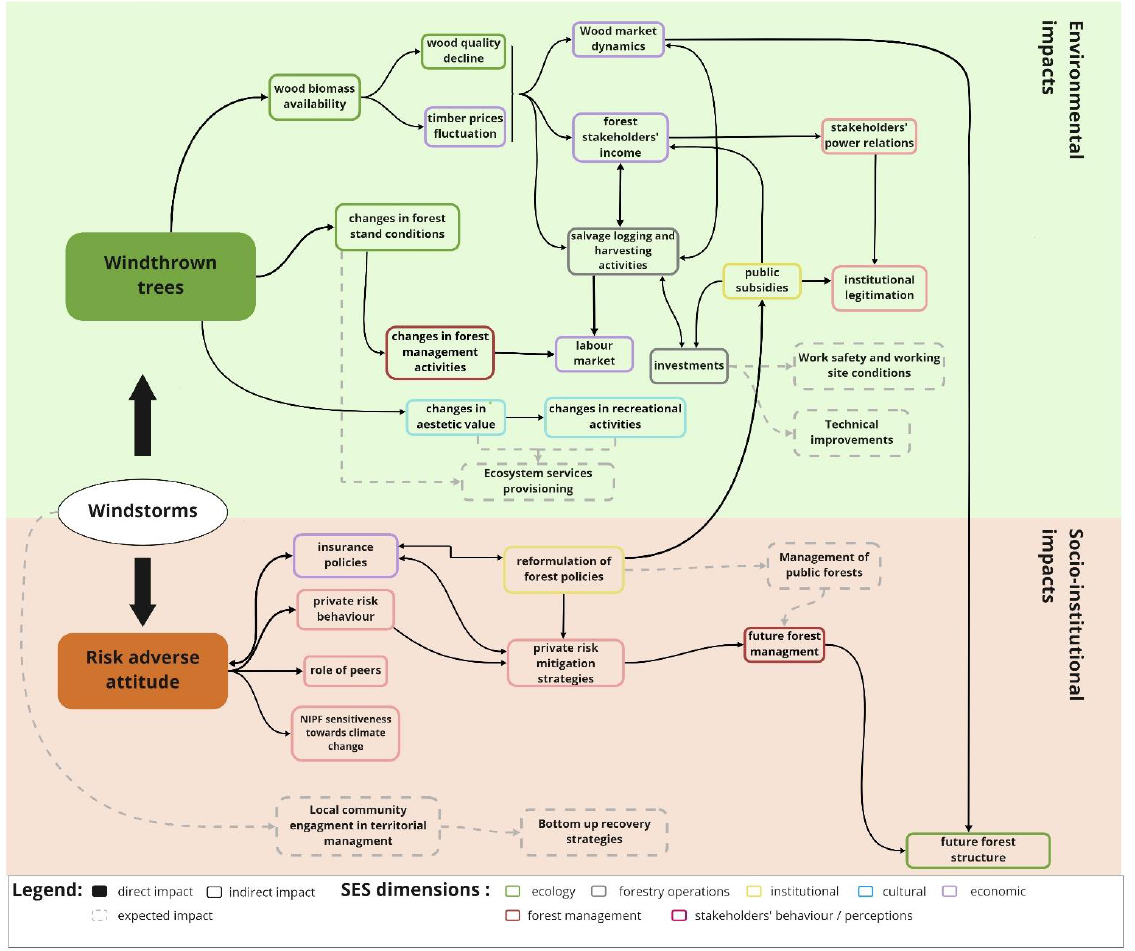
Figure 7. Causal map of the most relevant windstorm cause–effect linkages among forest SES dimensions and related knowledge gap as emerging from the articles analyzed. (Source: own elaboration).